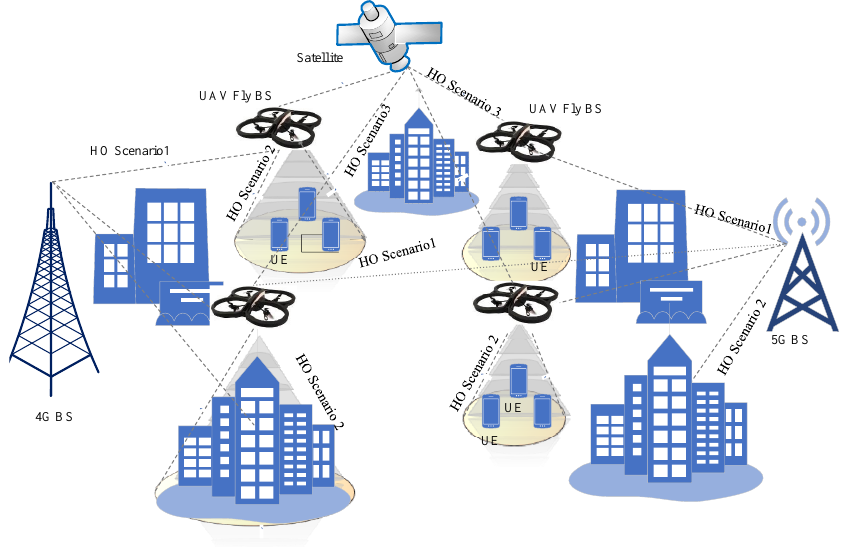
Figure 7. HO for UAVs as base stations in a future ultra–dense heterogenous network.